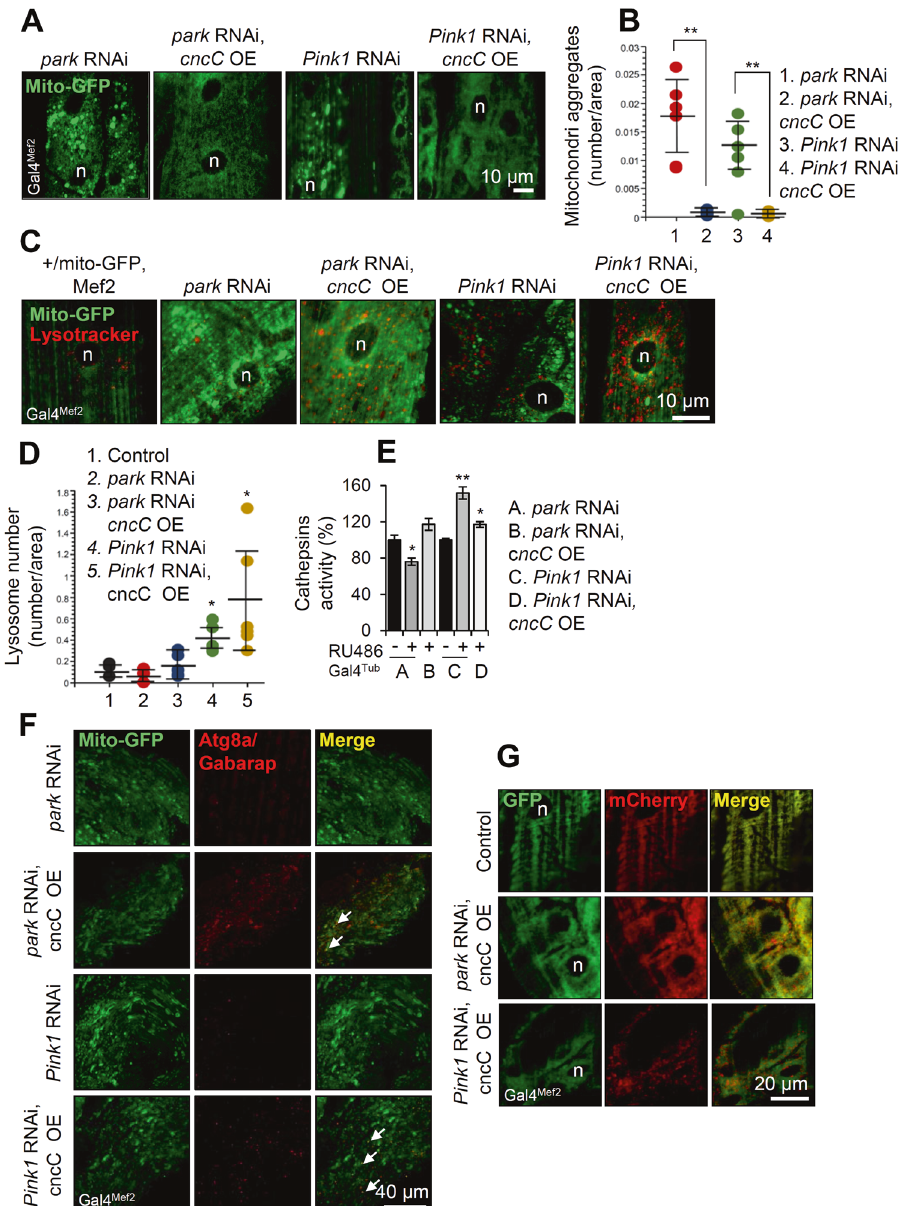
lysosomes (LysoTracker Red) co-staining and ( D ) quanti fi cation of lysosomes in the shown fl ies ’ genotypes after muscle-targeted (Gal4 Mef2 ) Tg expression. E Relative (%) cathepsin activity in transgenic fl ies after ubiquitous (Gal4 Tub ) park or Pink1 KD and concomitant cncC/Nrf2 OE. F CLSM viewing of mitochondria (Mito-GFP) and Atg8a/Gabarap immunostaining at the muscles (Gal4 Mef2 driver) of shown adult transgenic fl ies. G CLSM visualization of the Mito-QC reporter GFP and mCherry signal at the indicated transgenic larvae wall muscle (Gal4 Mef2 driver). Bars, ±SD; n = 3, * P < 0.05; ** P <